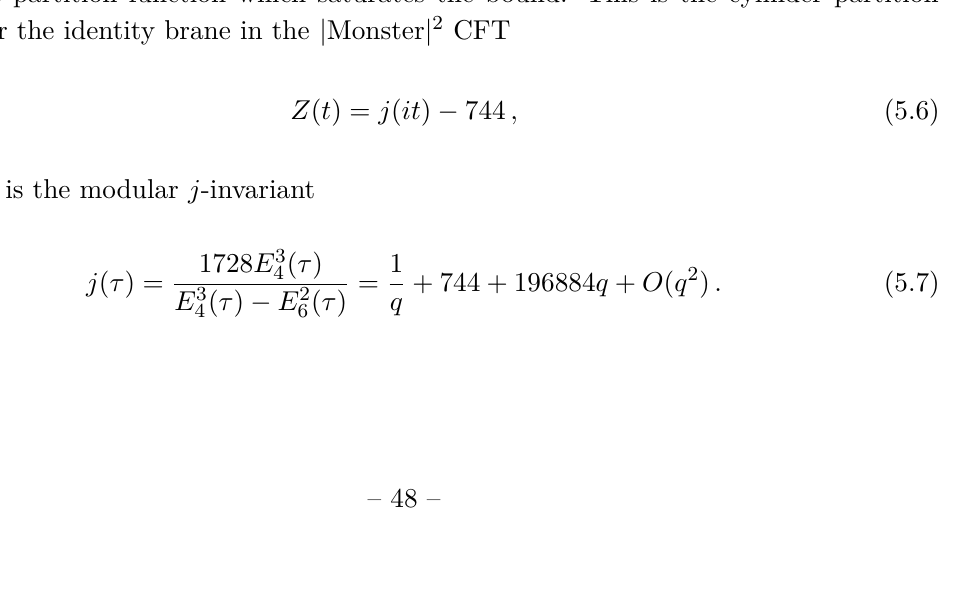
Figure 10. The action of the functional ω upper plot) and boundary (lower plot) characters. For clarity, we plot e 9∆ / 4 ω upper e 9 h/ 2 ω upper [ χ h ( − 1 /τ )] . The numerical functional at N = 111 is indistinguishable from the an- c =8 alytic curve by the naked